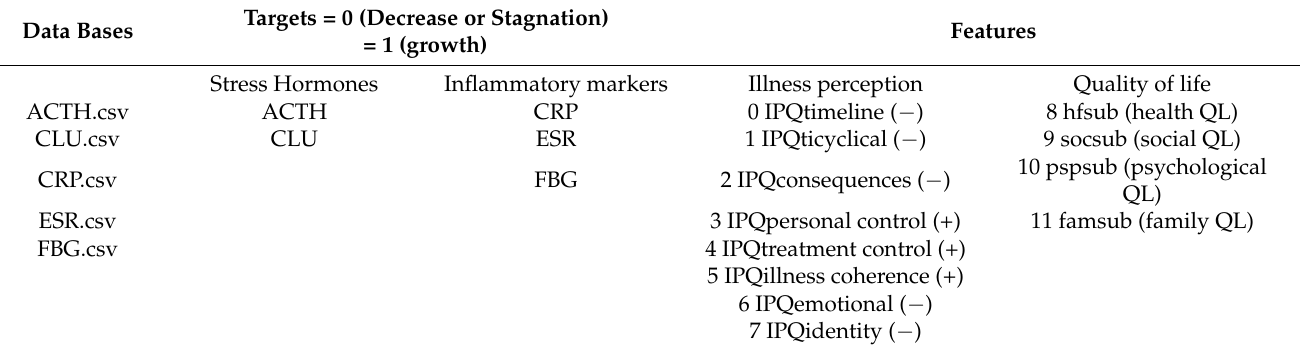
Table 8. Data bases, targets and features.